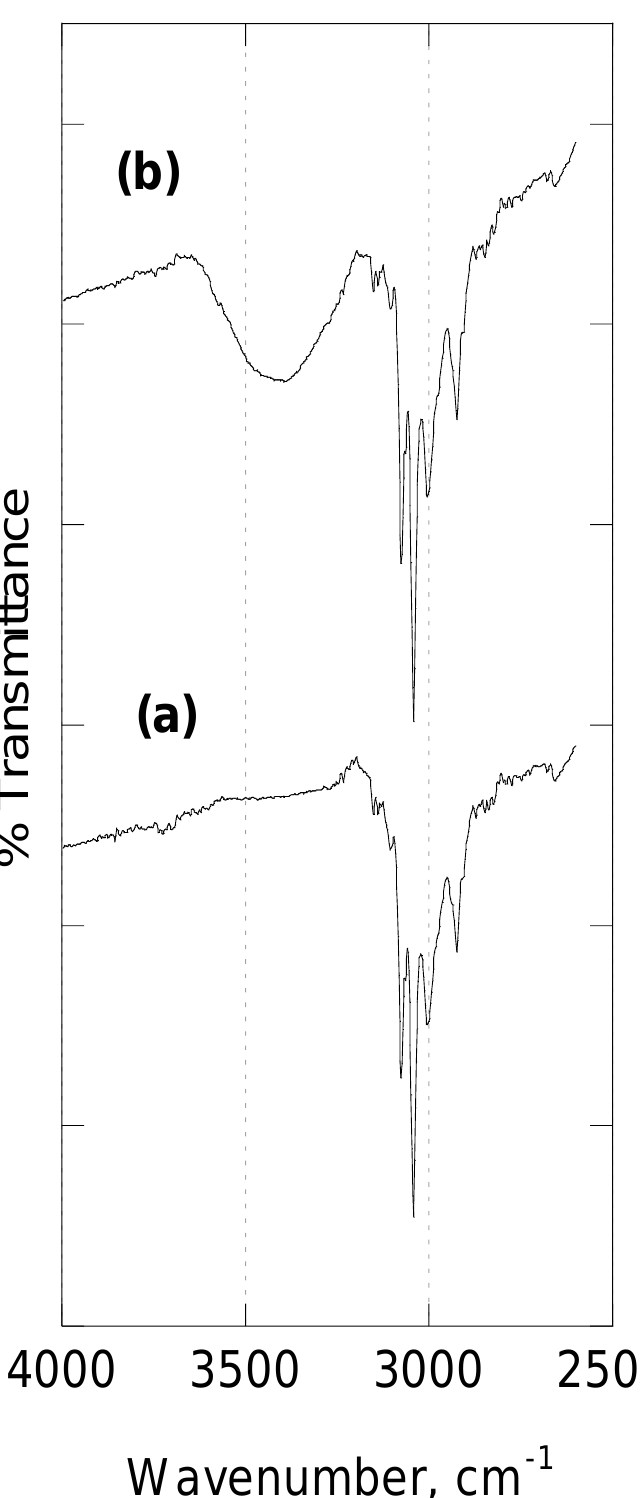
800 °C. The related XRPD pattern is reported in the supporting information (Figure S5).